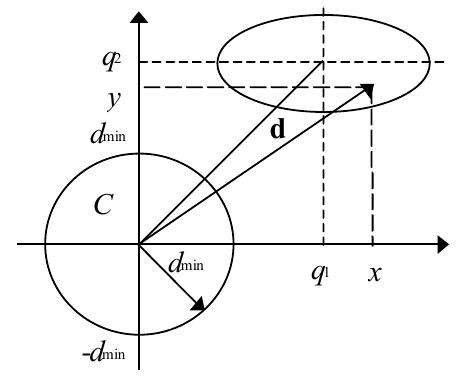
Fig 1. Geometric explanation of conflict probability